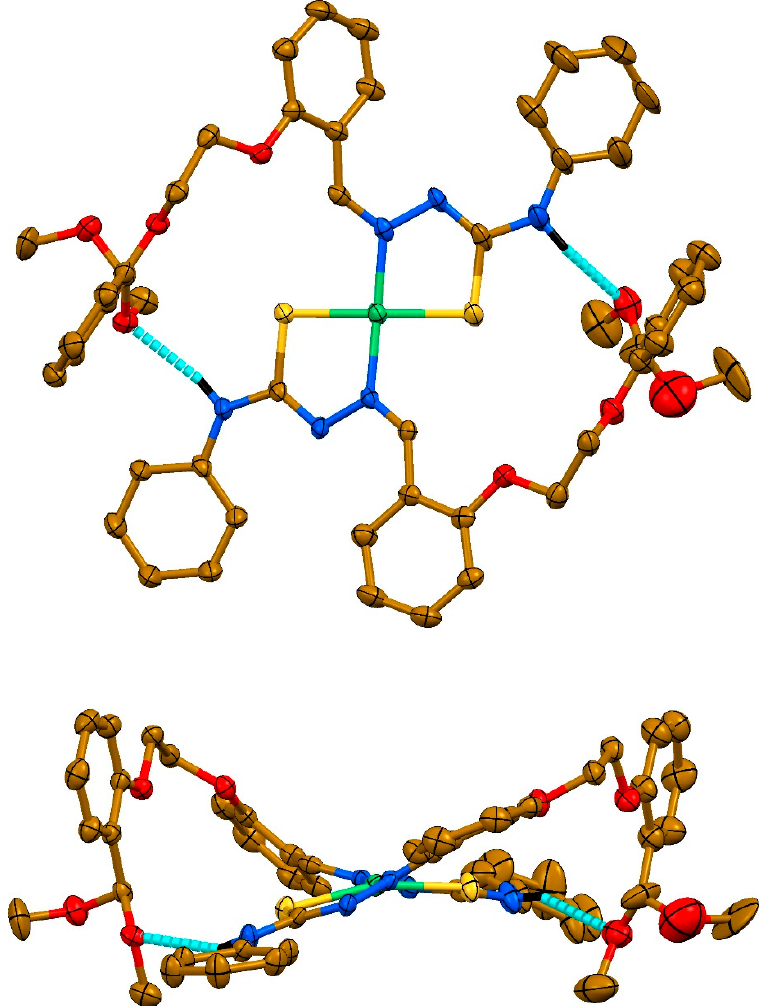
Figure 4. Top and side views on the crystal structure of 2 (ellipsoids are drawn with 40% probability; CH hydrogen atoms are omitted for clarity). Color code: C = gold, H = black, N = blue, O = red, S = yellow, Ni = green; N–H ∙∙∙ O hydrogen bond = cyan dashed line.